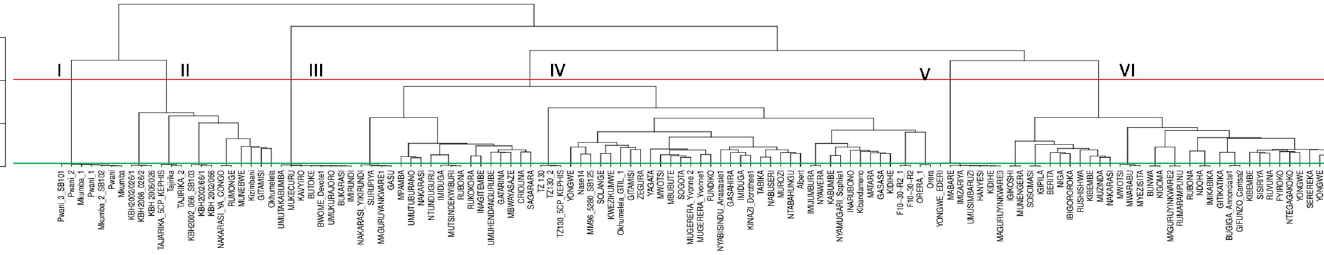
Fig 5. Genotypic classification of accessions based on the Ward’s method at dissimilarity level of 1.0 (red line), the green line determining the threshold for putative and known duplicates.